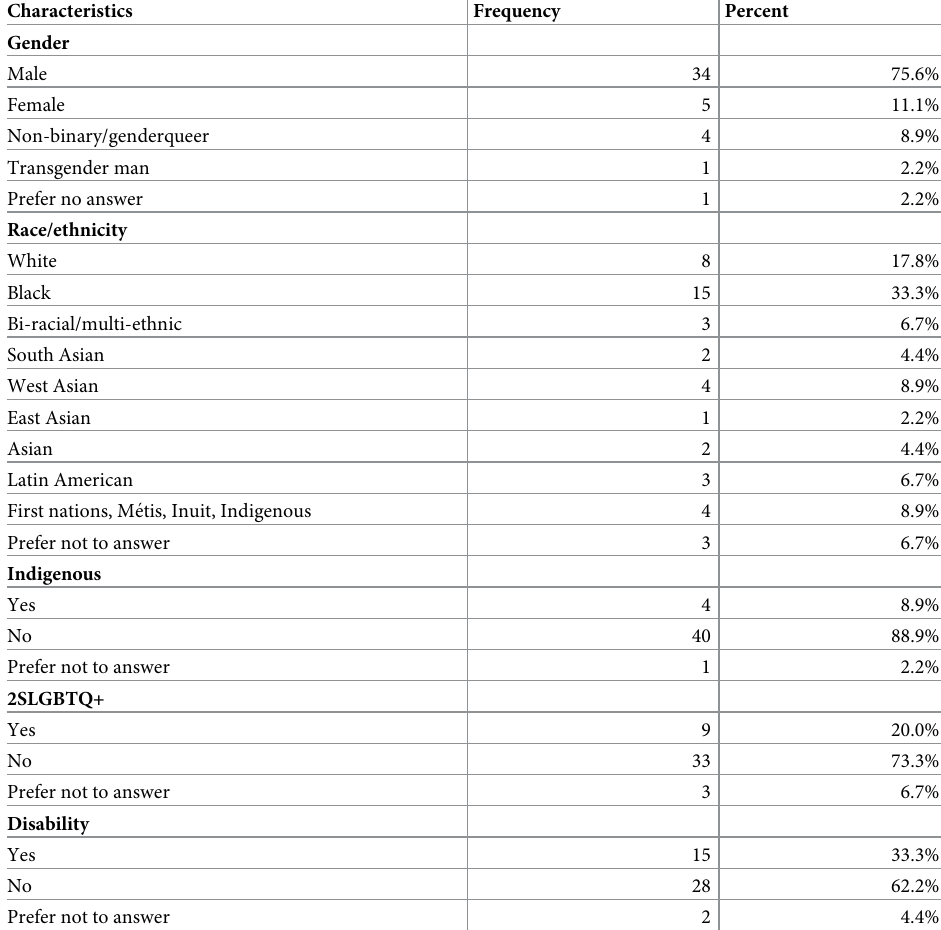
Table 1. Youth participant demographics.